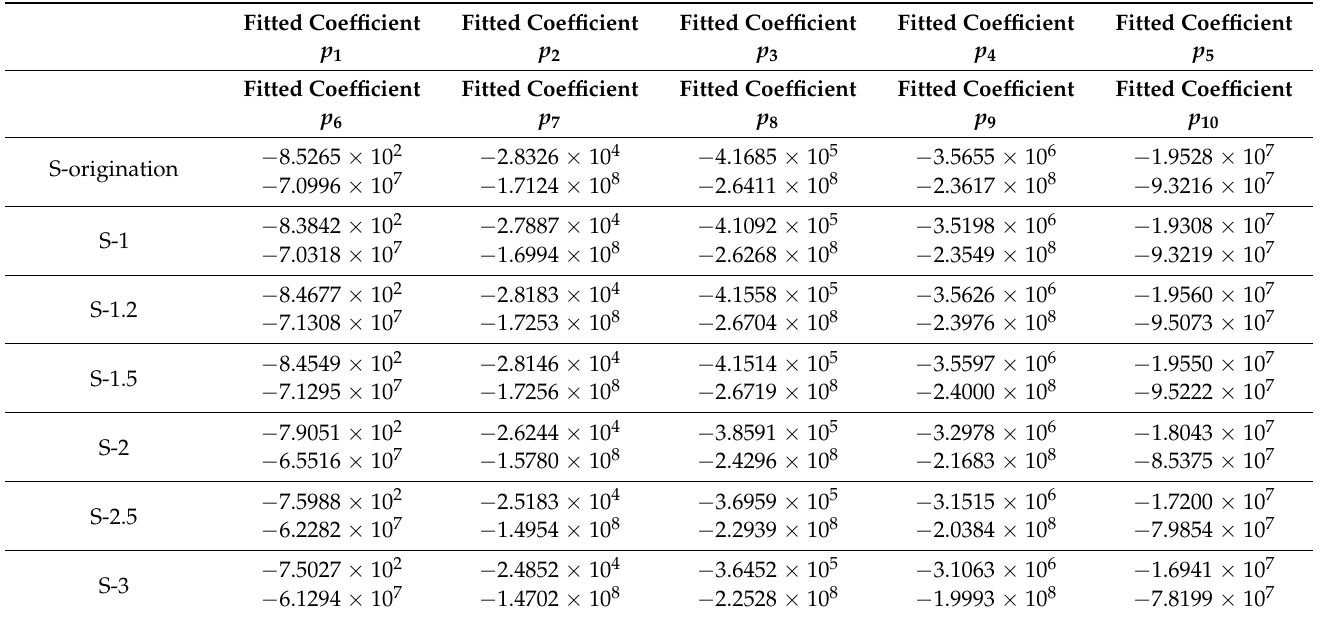
Table 11. The parameters of curve fitted function of NS-LS.